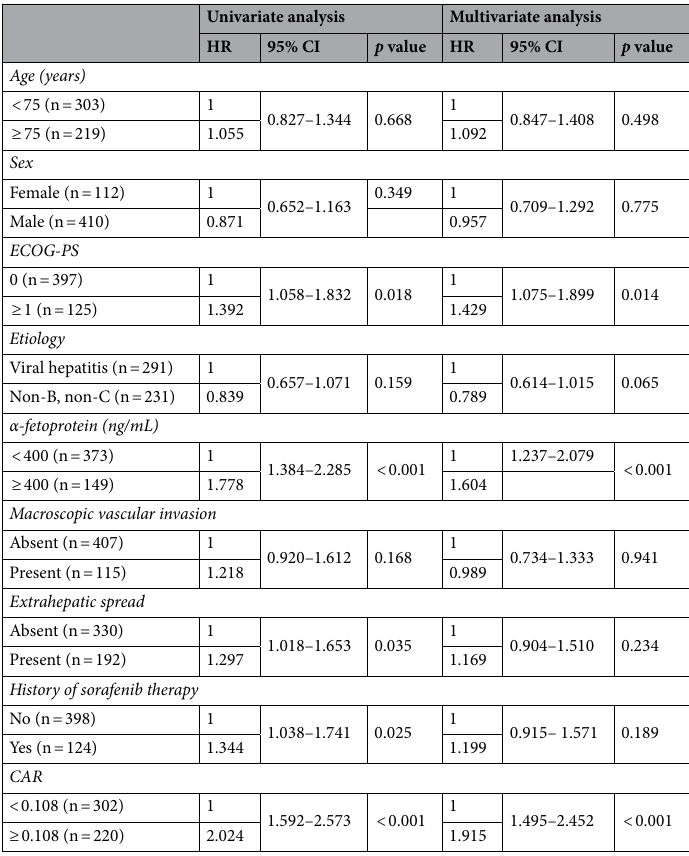
Table 2. Overall survival analysis. HR Hazard ratio; CI Confidence interval; ECOG-PS Eastern Cooperative Oncology Group Performance Status; CAR C-reactive protein to albumin ratio.